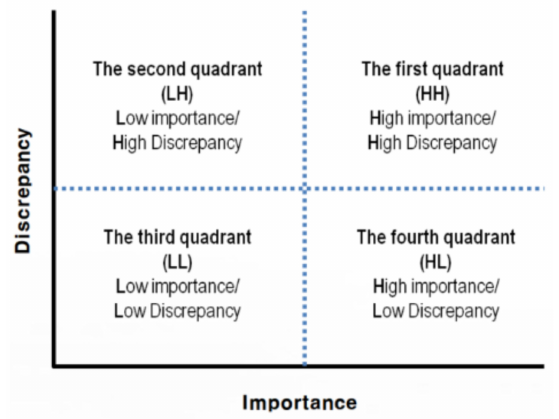
Figure 6. Locus for focus model [12].